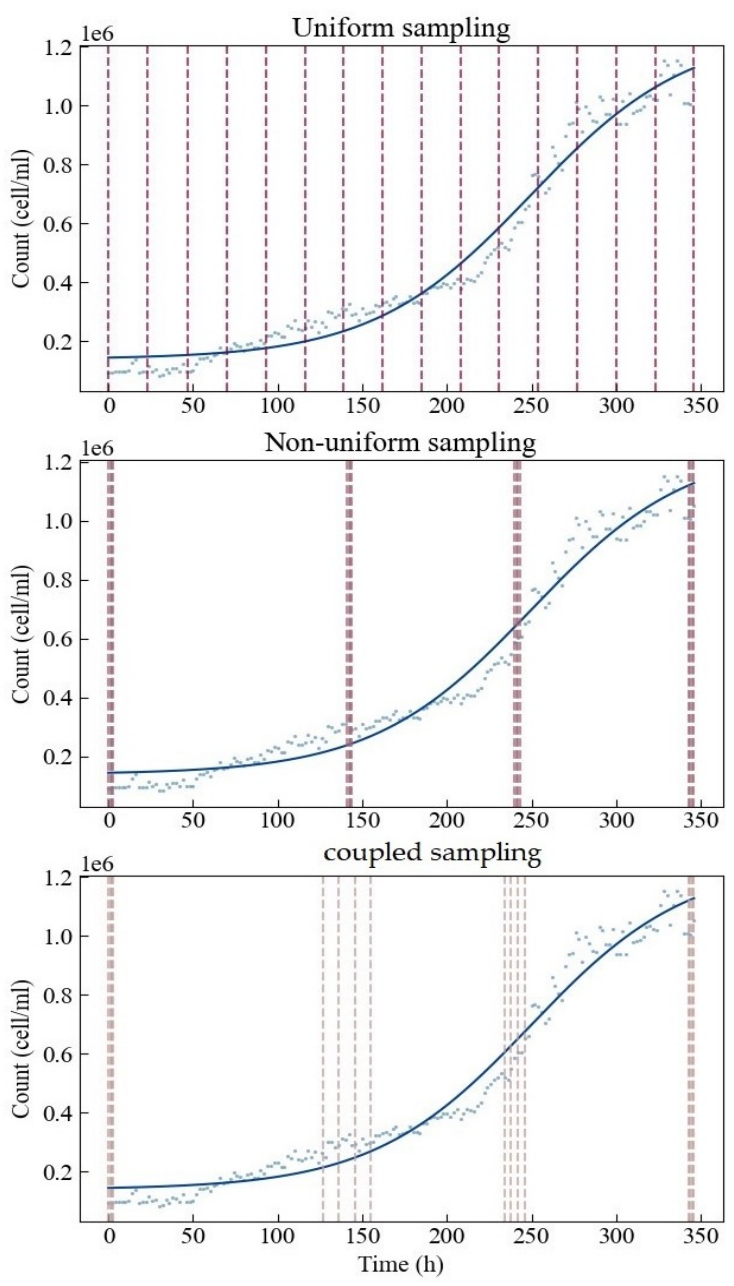
Figure 4. Specific sampling implementation plans for three different sampling methods.